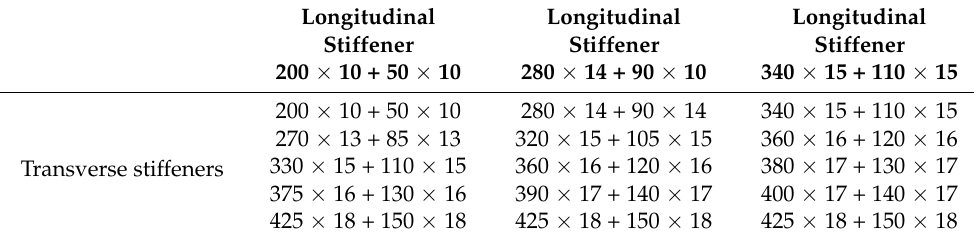
Table 5. Longitudinal and transverse stiffener combinations considered.